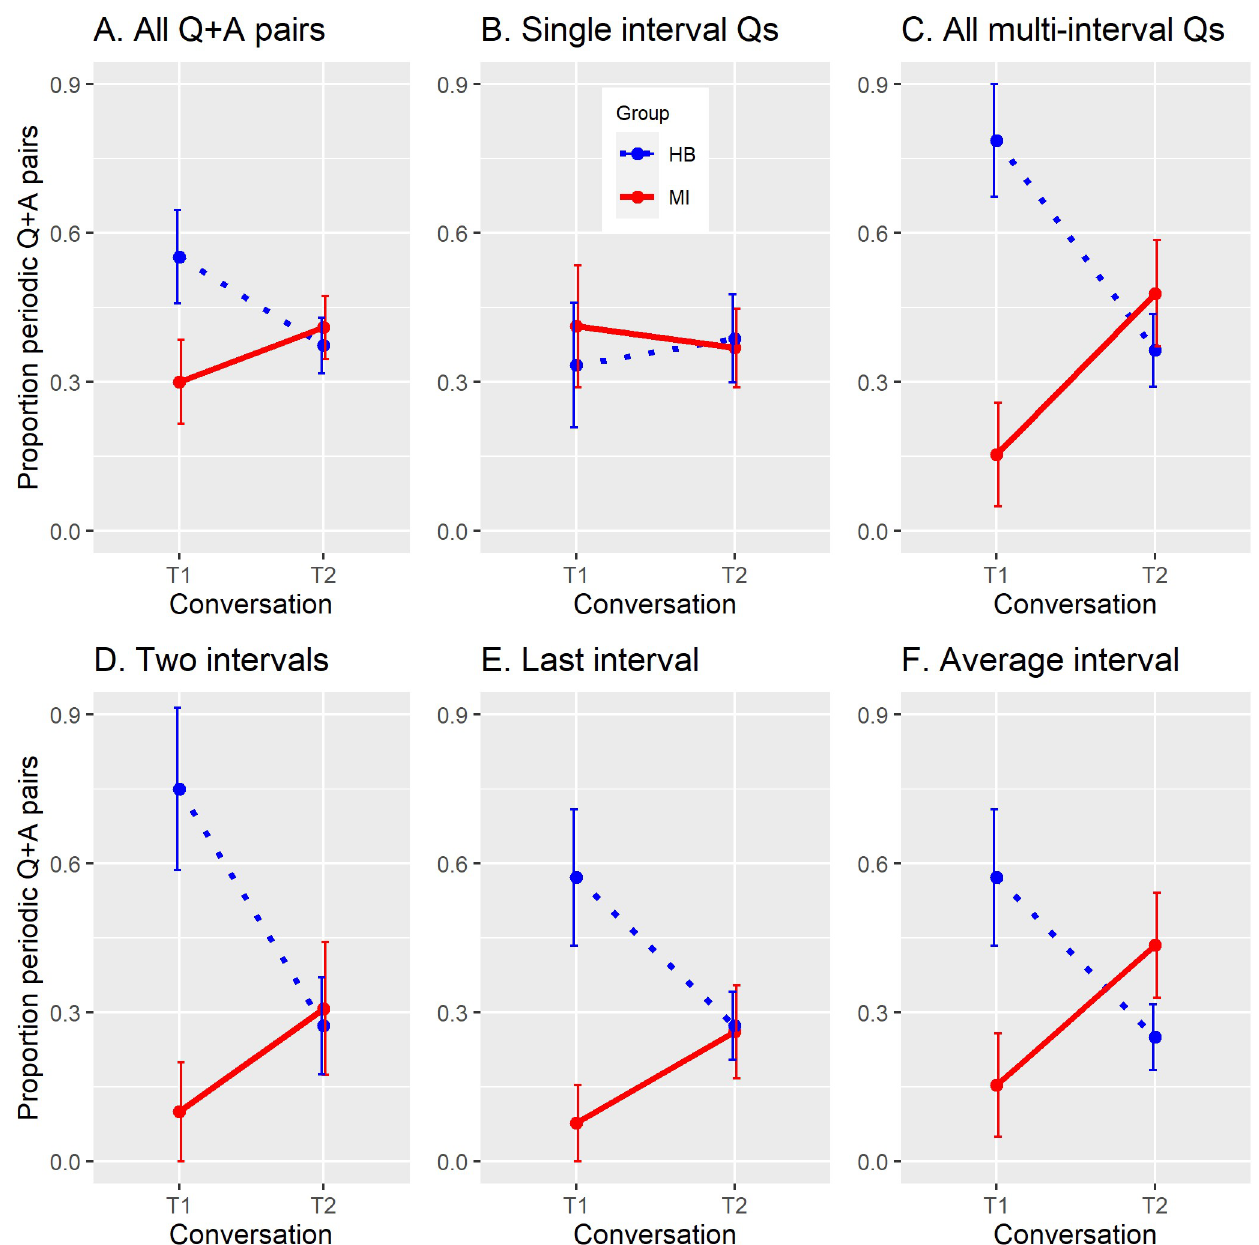
Fig 4. Proportion of periodic Q+A pairs per group (MI, HB) and conversation (T1, T2). A: total Q+A pairs. B: single-interval Q+A pairs only (1interval measure). C: all multi-interval Q+A pairs, on all three measures. Bottom row: Multi-interval pairs, for each of the three different measures. D: 2interval. E: last interval (using 1interval measure). F: AverageInterval. Line graphs are used to emphasize the effect of interest. Group MI: solid red. Group HB: dotted blue. Error bars: standard error.